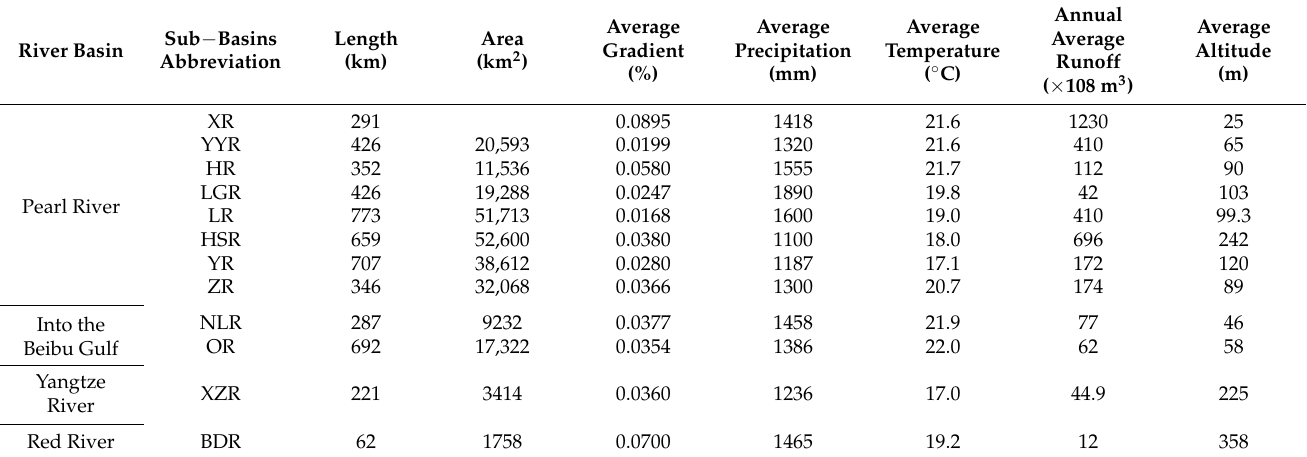
Table 1. Hydrological and environmental characteristics of 12 sub − basins in four basins, Guangxi.